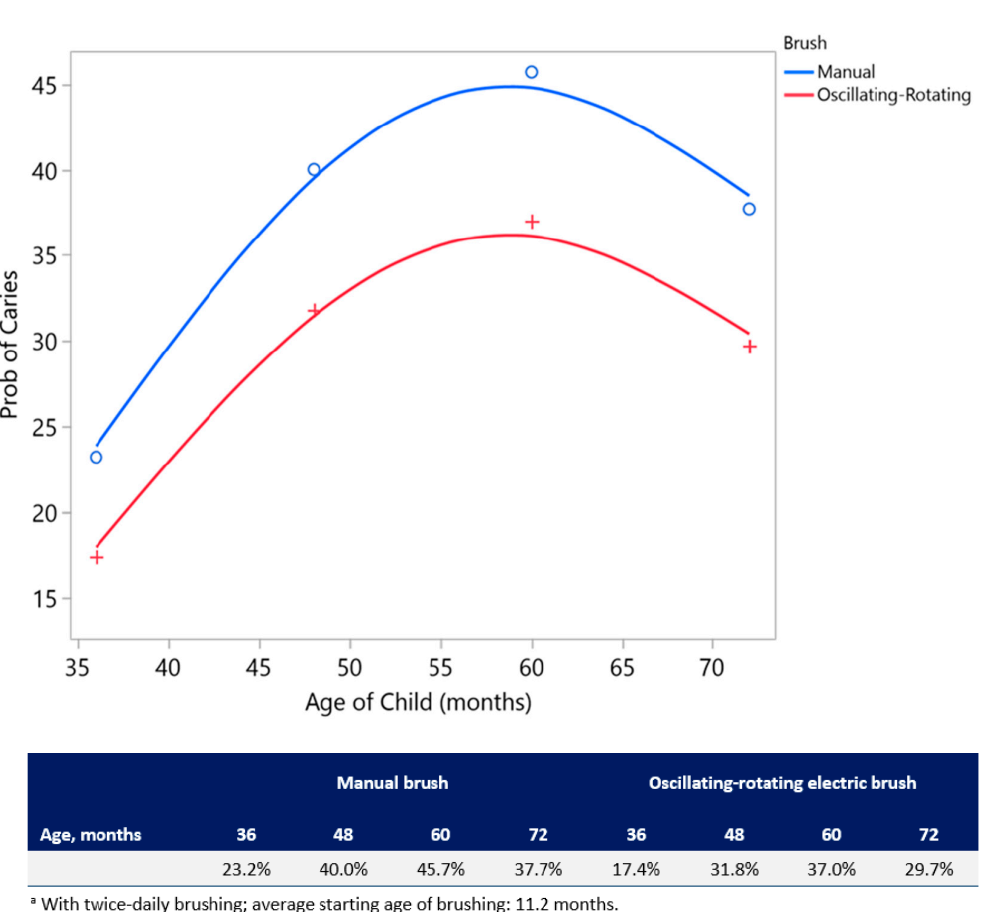
Figure 4. Probability a of having caries by Brush Type and Age (months) from the model in Table